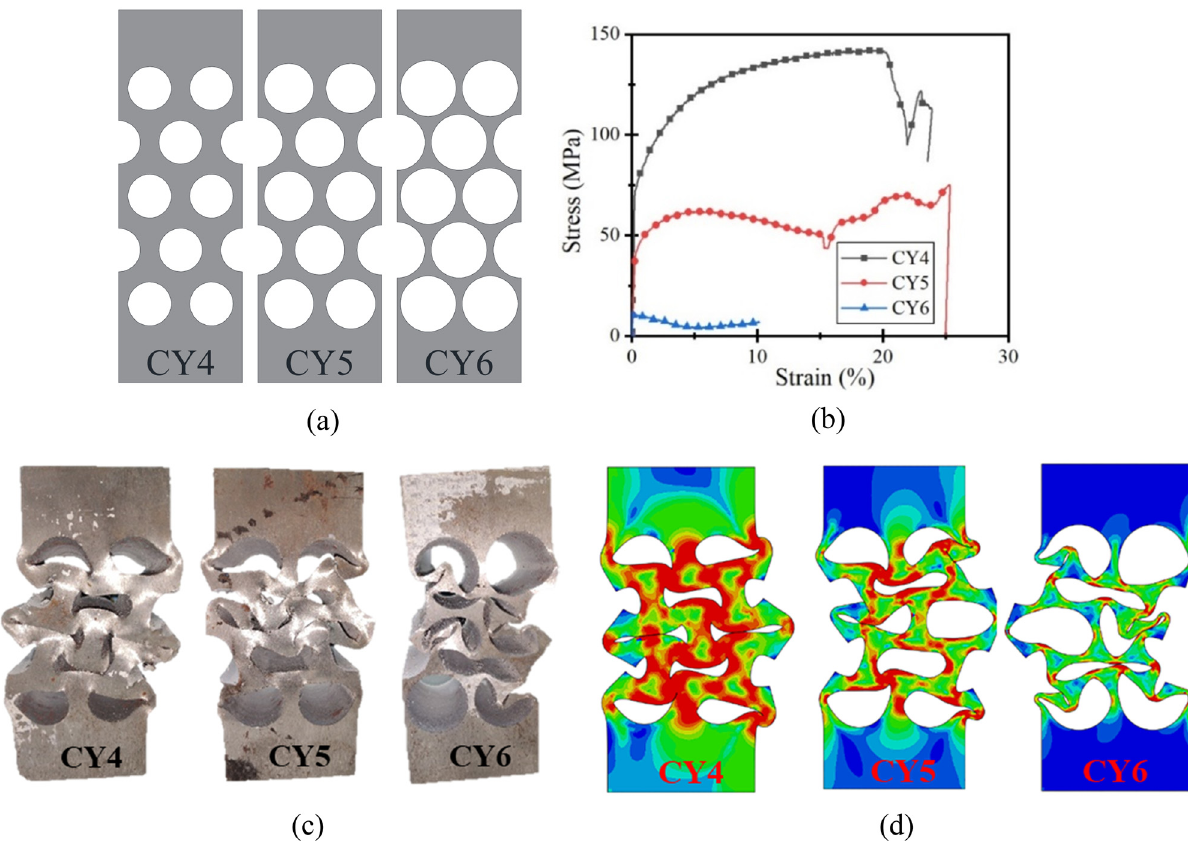
Figure 8: The e ff ect of void ratio: ( a ) hole arrangement, ( b ) stress – strain curves, ( c ) failure mode in test, and ( d ) failure mode in FEM.